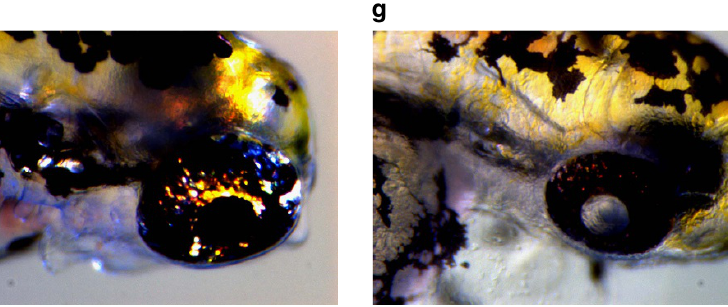
Figure 4 | In vivo modelling reveals broader developmental defects and underdeveloped cataractous lenses in dnajb1 a morphants. dnajb1a zebrafish morphants recapitulate PA symptoms. Dorsal view of ( a ) control morphant and ( b ) dnajb1a morphant embryos suggest a relatively compact lens observed at 4 days post fertilization as a result of dnajb1a MO. Lateral view of ( c ) control morphant and ( d ) dnajb1a morphant embryos showing broader eye developmental defects including underdeveloped cataractous lenses in dnajb1a MO-injected embryos. ( e ) Quantification of the compact lens phenotype in the dnajb1a , hspa4l and kif3a morphants and rescue of morphant phenotype with zebrafish orthologue of dnajb1a mRNA. Note: kif3a MO did not show any ocular phenotype; however, the morphants exhibited morphological and developmental defects, such as body curvature, consistent with the ciliary phenotypes. Lateral view of ( f ) control morphant and ( g ) dnajb1b morphant embryos illustrate a relatively compact cataractous lenses observed at 4 days post fertilization as a result of dnajb1b translation-blocking